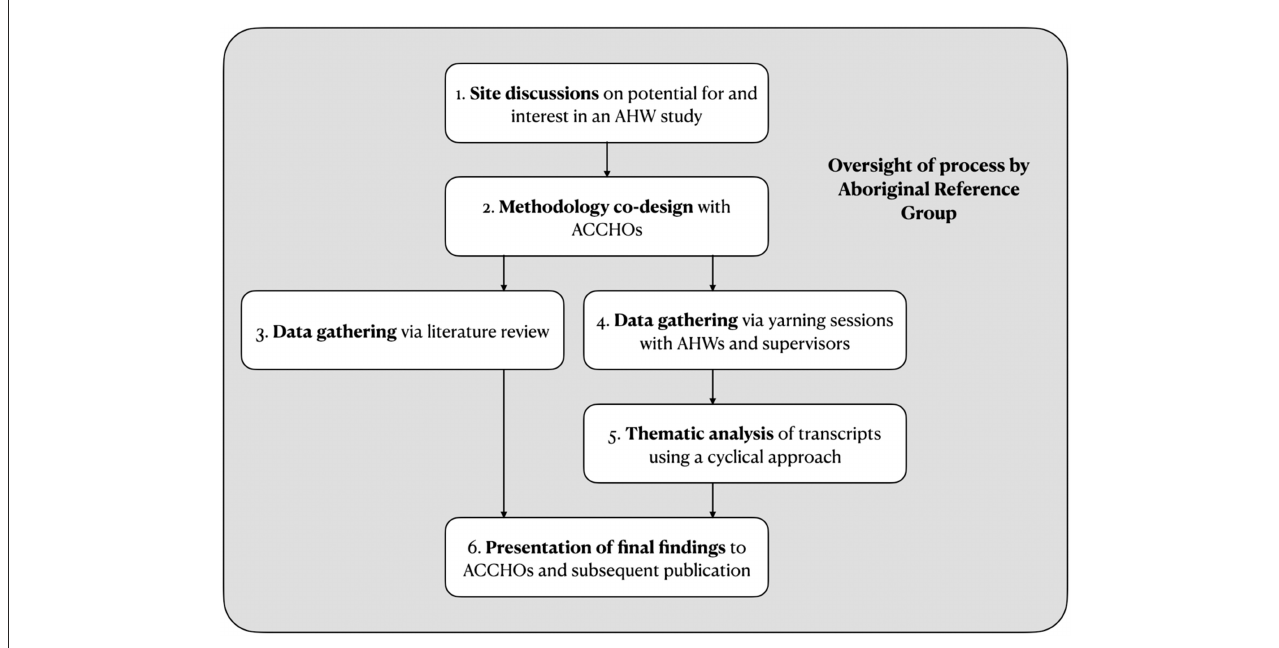
FIGURE1 Study design. This flowchart shows the steps involved in “Exploring the Role of Aboriginal Health Workers in PHC in New South Wales”. AHW, Aboriginal Health Worker; ACCHO, Aboriginal Community Controlled Health